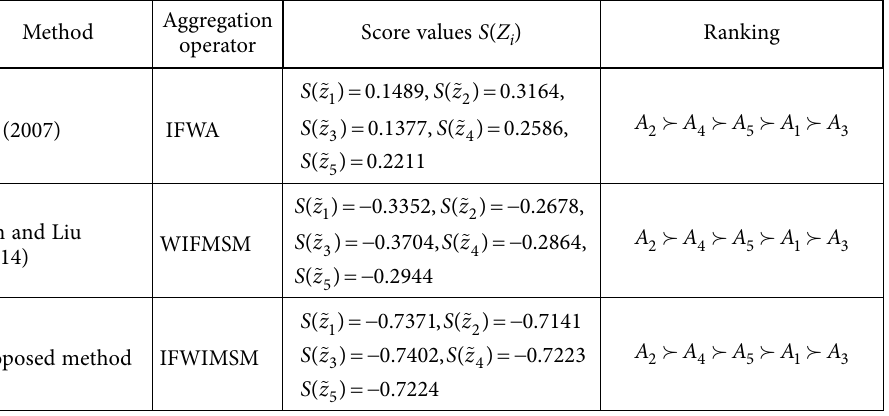
Table 5. Ranking results by different